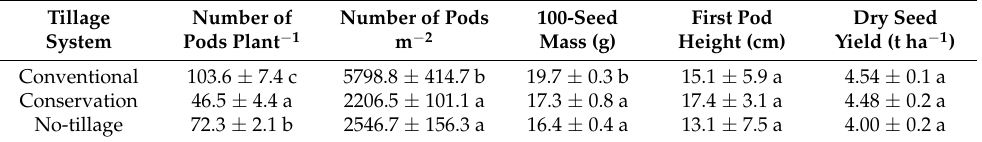
Table 2. Soybean yield components according to the different tillage systems. Tillage